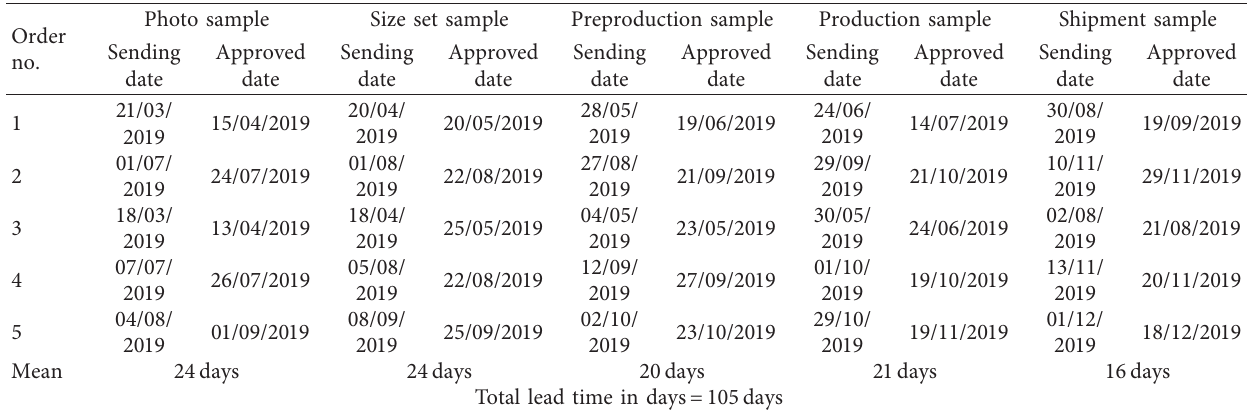
Table 3: Company C, date-wise sample approval data taken from five different orders.